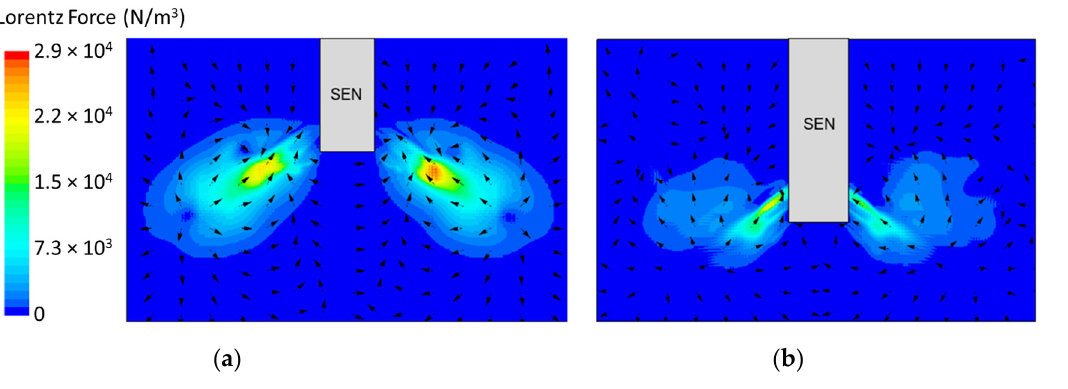
Figure 13. ( a ) Low SEN depth 110 mm (Case 4) vs. ( b ) high SEN depth 350 mm (Case 8) Lorentz force distribution.